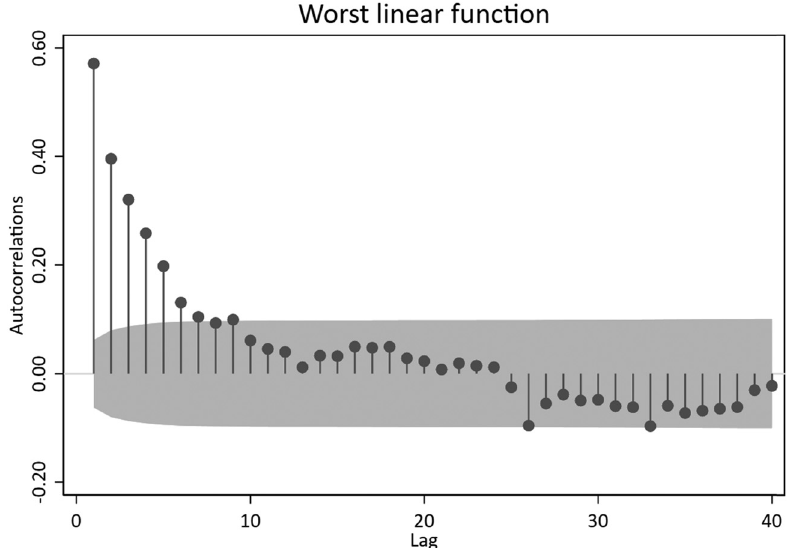
Figure A2: Autocorrelation plot of WLF ( Table 4/L&J ’ s reconstructed data )